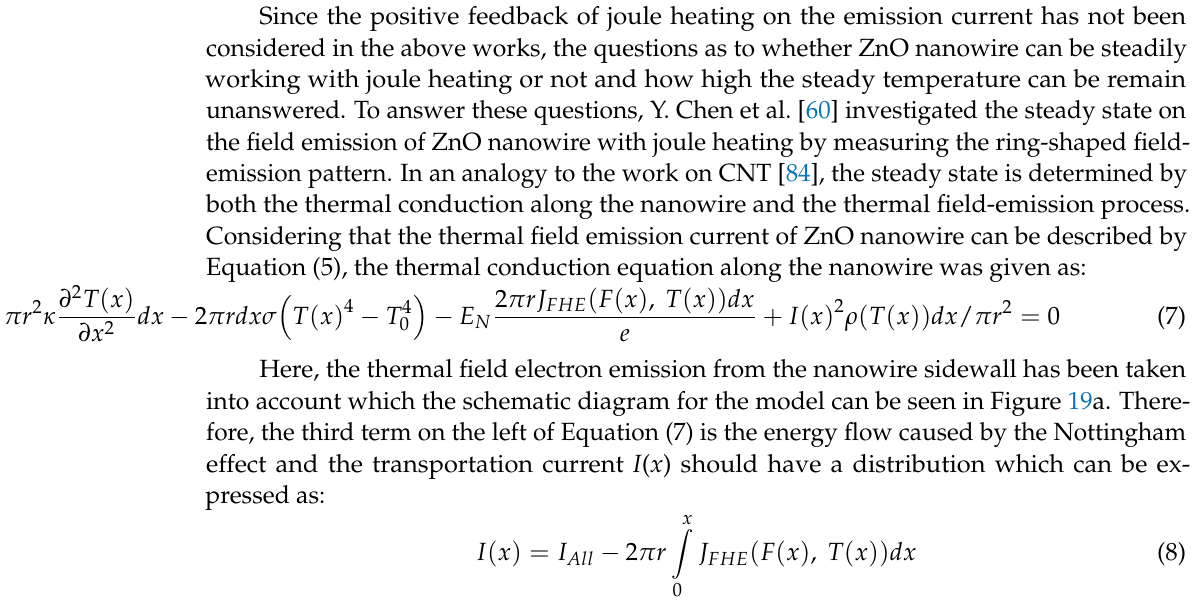
Figure 18. Joule heating induced vacuum breakdown in the field emission of ZnO nanowires. ( a ) The case when the applied field increased slowly. ( b ) The case when the applied field increased sharply. Reproduced from [53], with the permission of AIP Publishing, 2011. ( c , d ) The cases before and after vacuum breakdown for an individual nanowire. Reproduced from [65], with the permission of AIP Publishing, 2009.